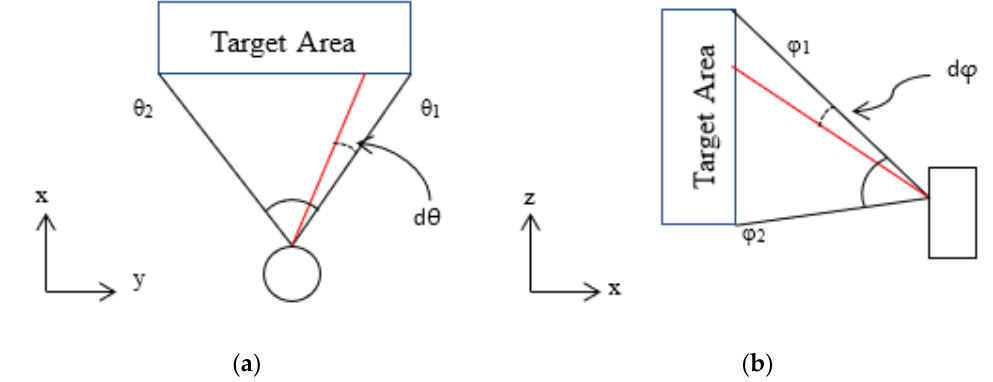
Figure 3. Illustration of field of view (FOV) of a typical 3D LiDAR scanner represented in orthogonal views. ( a ) Plane view; ( b ) side view.